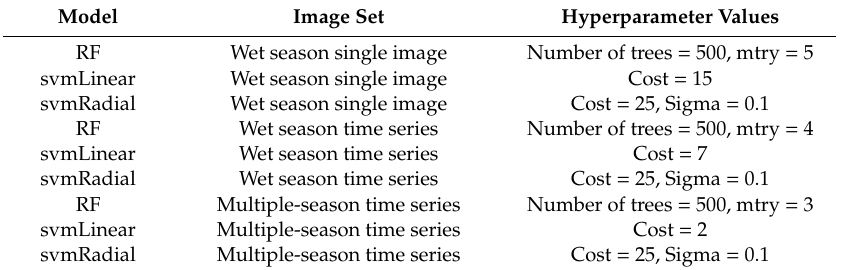
Table 4. Hyperparameter values used in 100 replicates for each Random Forest (RF) and Support Vector Machine (SVM) model, with values obtained from repeated k-fold validation with a manual